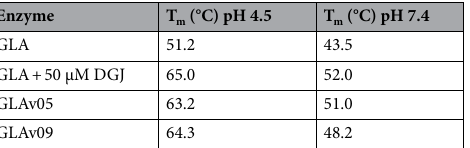
Table 1. Melting temperatures measured by differential scanning fluorimetry. DGJ = 1-deoxygalactonojirimycin.